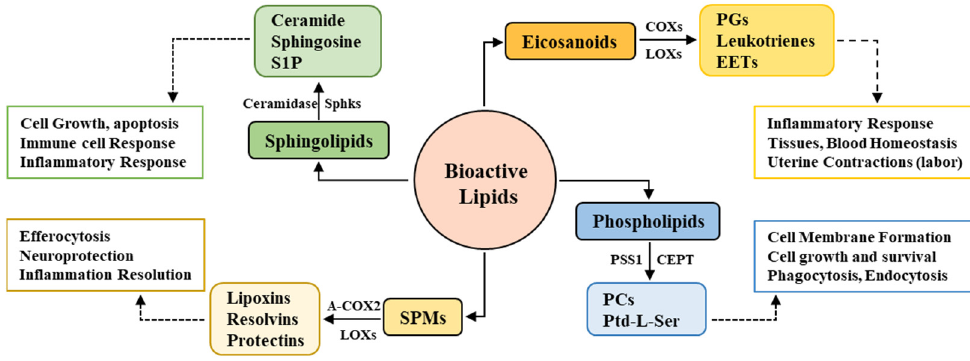
Figure 1. Bioactive lipids, major enzymes, and functional roles.